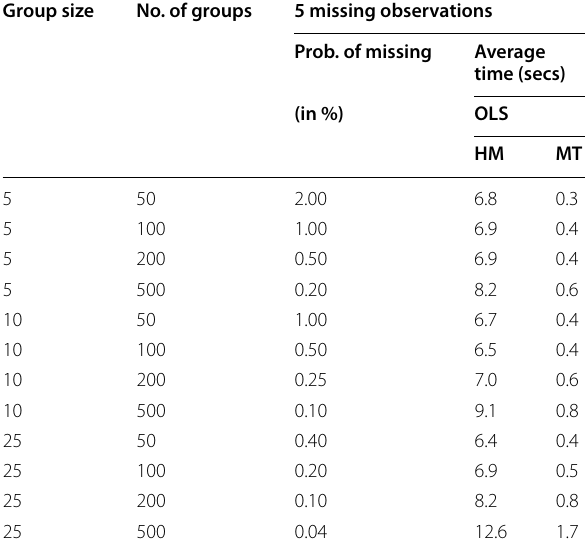
pseudo-standard normal numbers, with respective sup- ports between [0, 4] , [0, 1] , [1.25, 4.125] and [